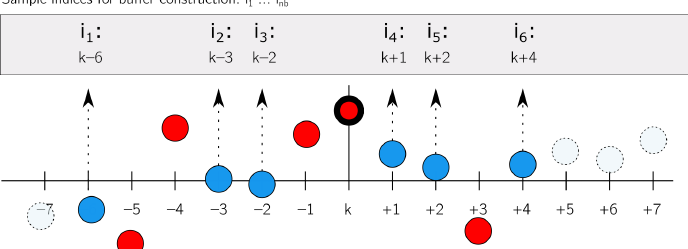
Figure 5. Illustration of the buffer construction (sample selection) with n b = 6 samples for an outlier at index k , and the effect of outliers on the effective buffer length. Red circles indicate outliers, which will not be included in the buffer; blue circles indicate nominal difference samples and dashed circles indicate samples outside the buffer.